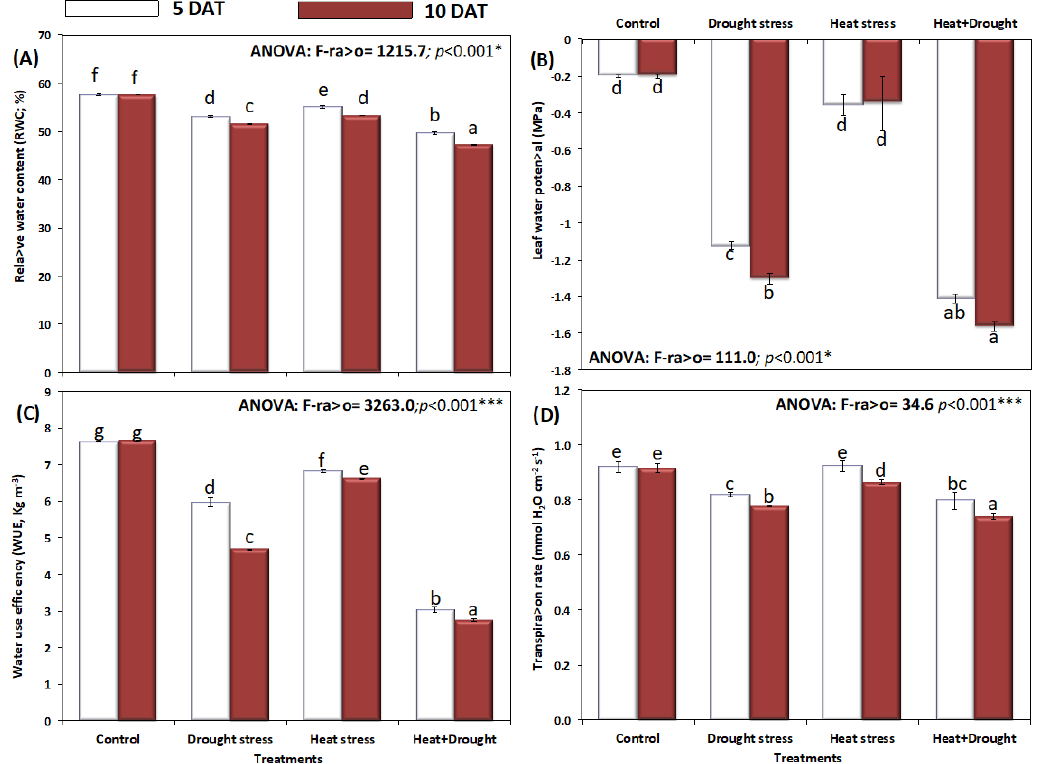
Figure 6. Effect of drought, heat, and interaction between drought and heat stresses on ( A ) relative water contents (RWC %), ( B ) leaf water potential (MPa), ( C ) water use efficiency (WUE), and ( D ) transpiration rate of A. sieberi alba. Data expressed as mean of triplicates, error bars represent standard error for means. Means marked with different letters are significantly different according to ANOVA and DMRTs at p < 0.05.